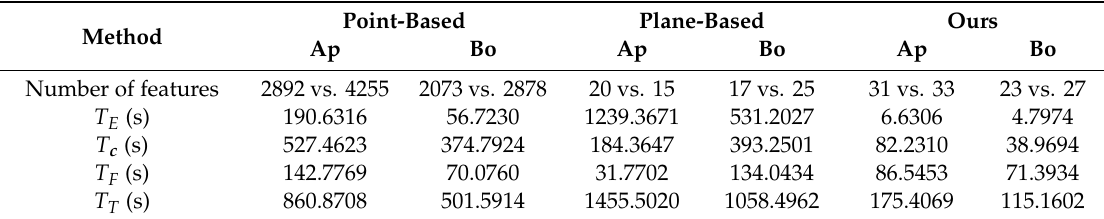
Table 2. The number of features and the time spent on each phase for the three methods on the indoor dataset. T E denotes the time for feature extraction, T c denotes the time for coarse registration, T F denotes the time for fine registration, and T T denotes the total time.